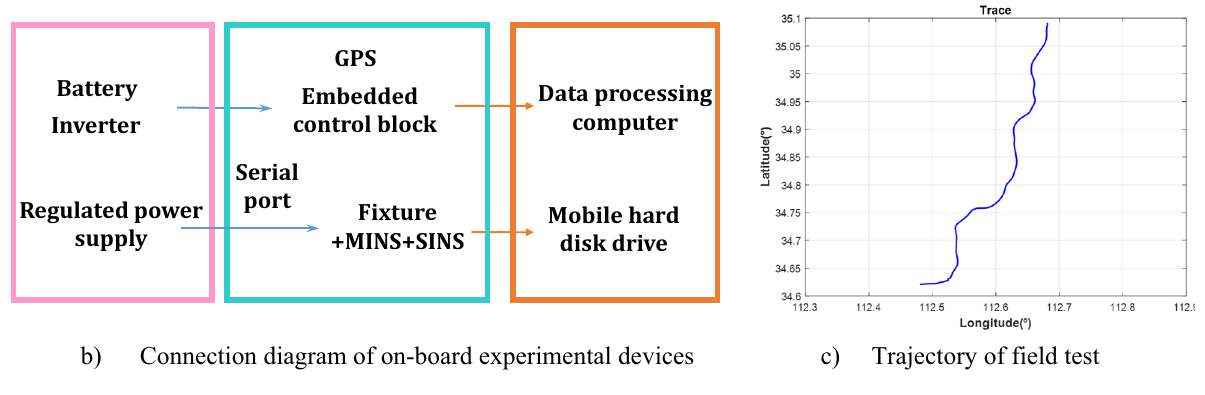
Figure 6. The vehicle experiment test platform and the tested